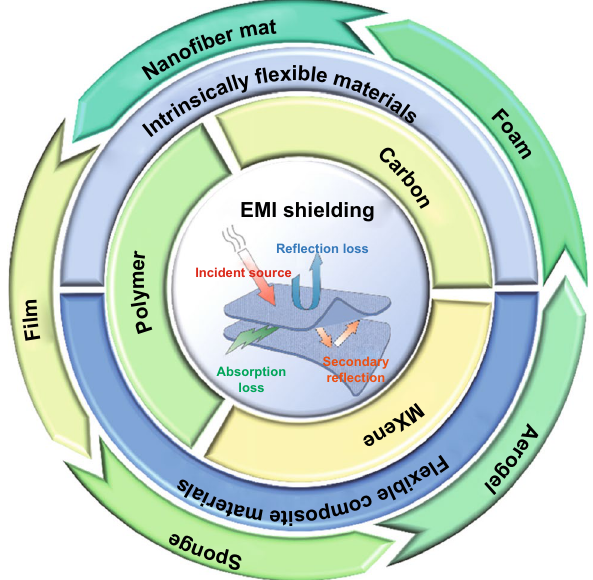
Fig. 6 Application of flexible nanocomposite in EMI